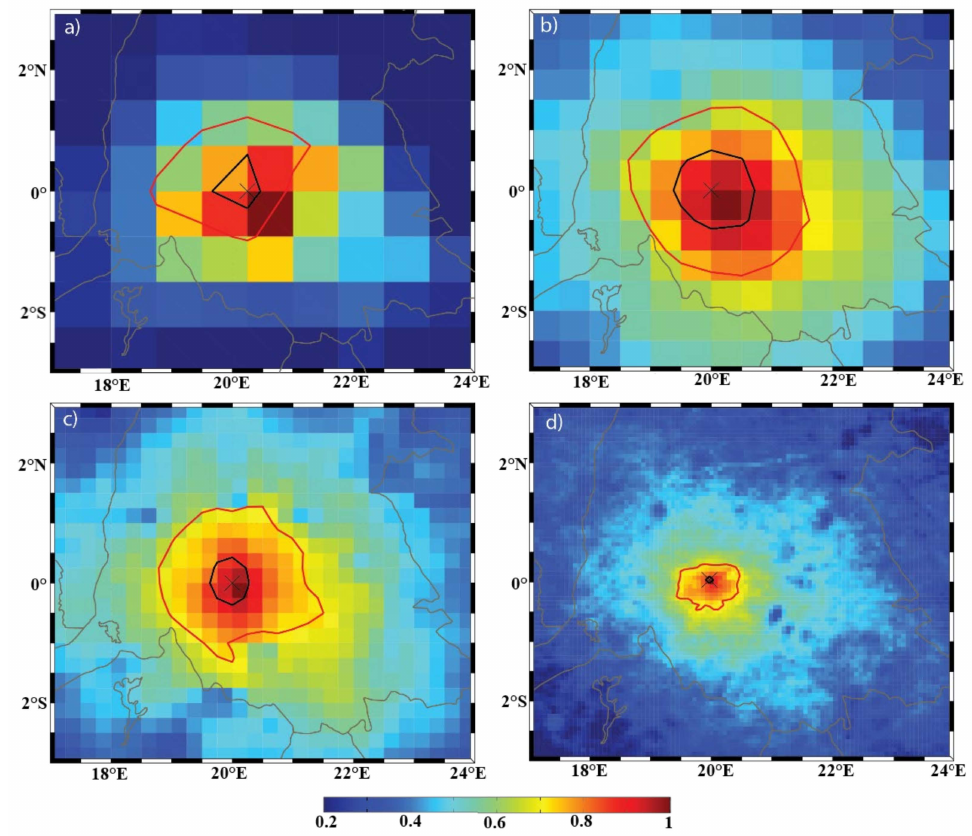
Figure 10. An example of the DCLS calculation of the precipitation field for the ( a ) ERA-I; ( b ) eERA5; ( c ) ERA5; and ( d ) ECOA datasets from 2016–2017. The background color represents the correlation coefficient values, the black contour represents the 0.9 contour level, and the red contour represents the 0.7 contour